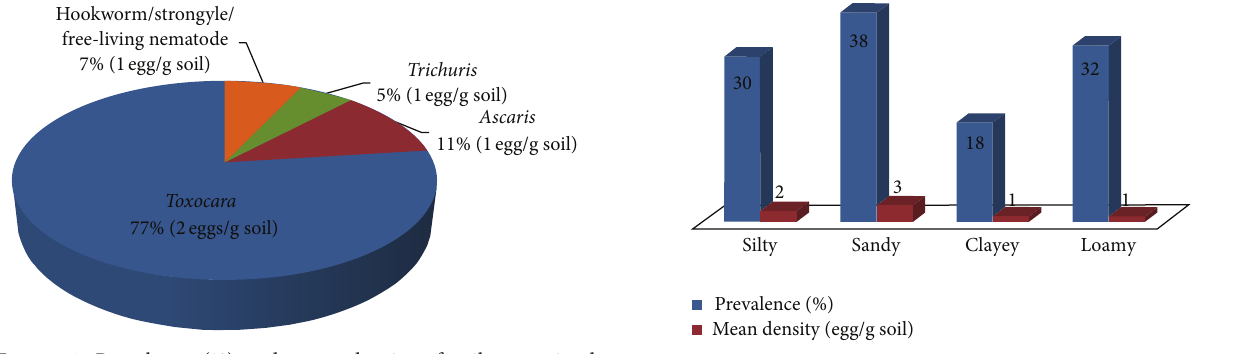
Figure 3: Prevalence and mean density of Toxocara eggs in different soil textures from selected towns in Laguna, Philippines. Table 1: Some physicochemical characteristics of soils from selected towns in Laguna,